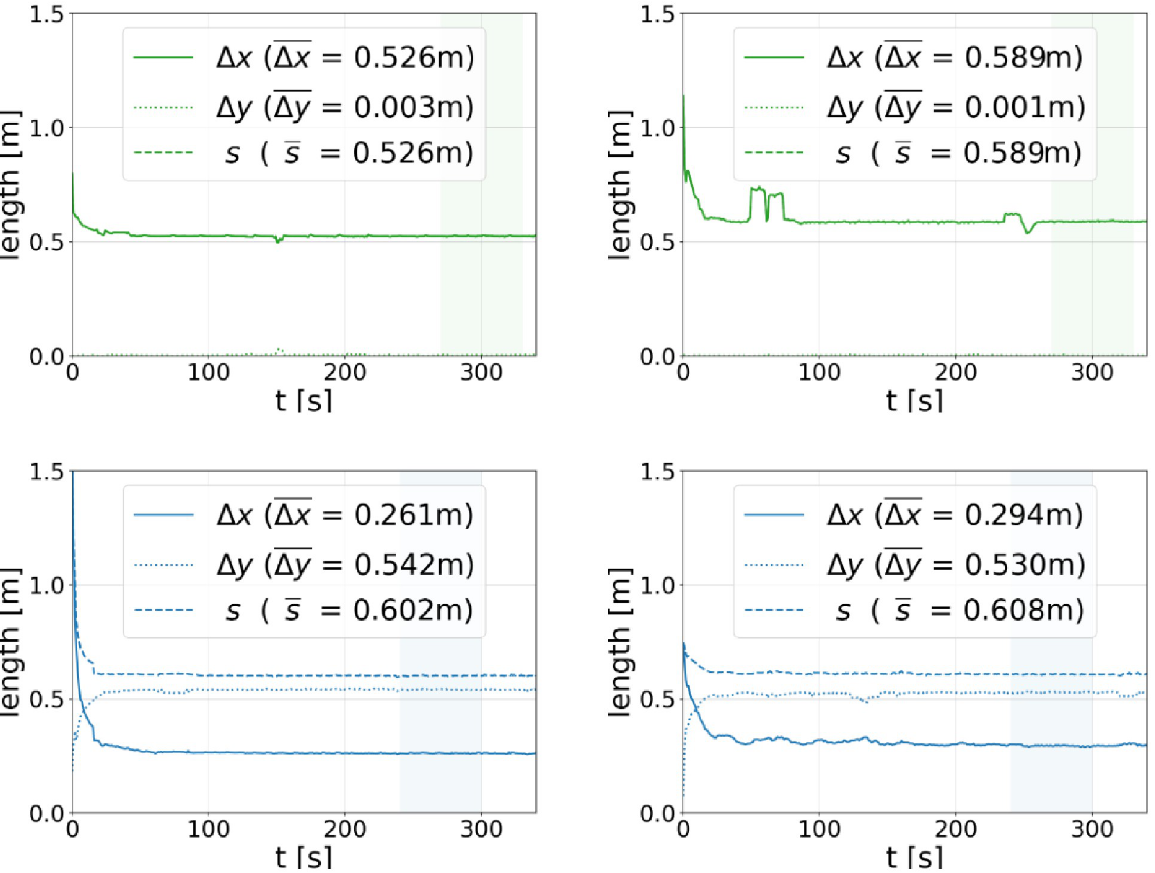
Fig 5. Simulation results for spatial distances between the agents. Shown are results for the clear widths w = 0.6 m (first row) and w = 1.0 m (second row), as well as for the escalator speeds v esc = 0.5 ms − 1 (left) and v esc = 0.75 ms − 1 (right), respectively. The average values of the distances are obtained from steady-state regions of 60s length (shaded areas) and are indicated by a bar. Since Δ y almost vanishes in the upper two diagrams, the total distance s is approximately the same as Δ x .